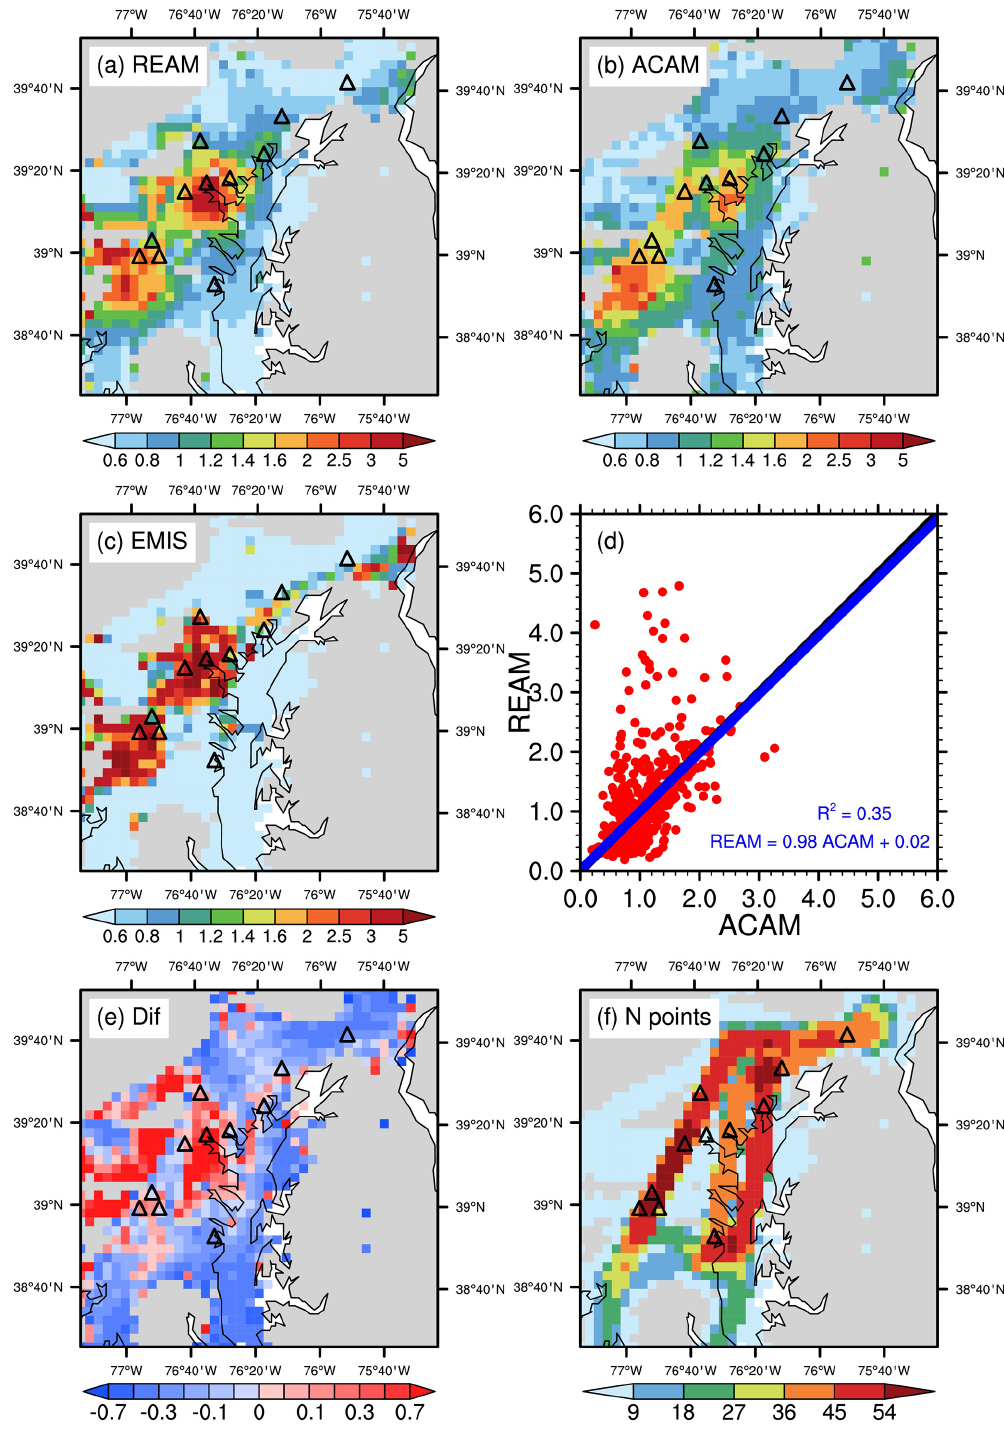
Figure 14. Distributions of the scaled mean (a) 4km REAM-simulated NO 2 VCDs below the UC-12 aircraft and (b) coincident ACAM measurements on weekdays in July 2011. (c) The distribution of the scaled NEI2011 NO x emissions on weekdays. (d) The scatterplot of the scaled 4km REAM and ACAM NO 2 VCDs from (a, b) . Panel (e) shows the relative differences between (a) and (b) (REAM / ACAM − 1). (f) The distribution of the number of data points used to calculate grid cell mean NO 2 VCDs in (a, b) . Here, we scale all values (VCDs and NO x emissions) based on their corresponding domain averages. The domain averages of ACAM and coincident 4km REAM NO 2 VCDs are 4.7 ± 2.0 and 4.6 ± 3.2 × 10 15 moleculescm − 2 ,